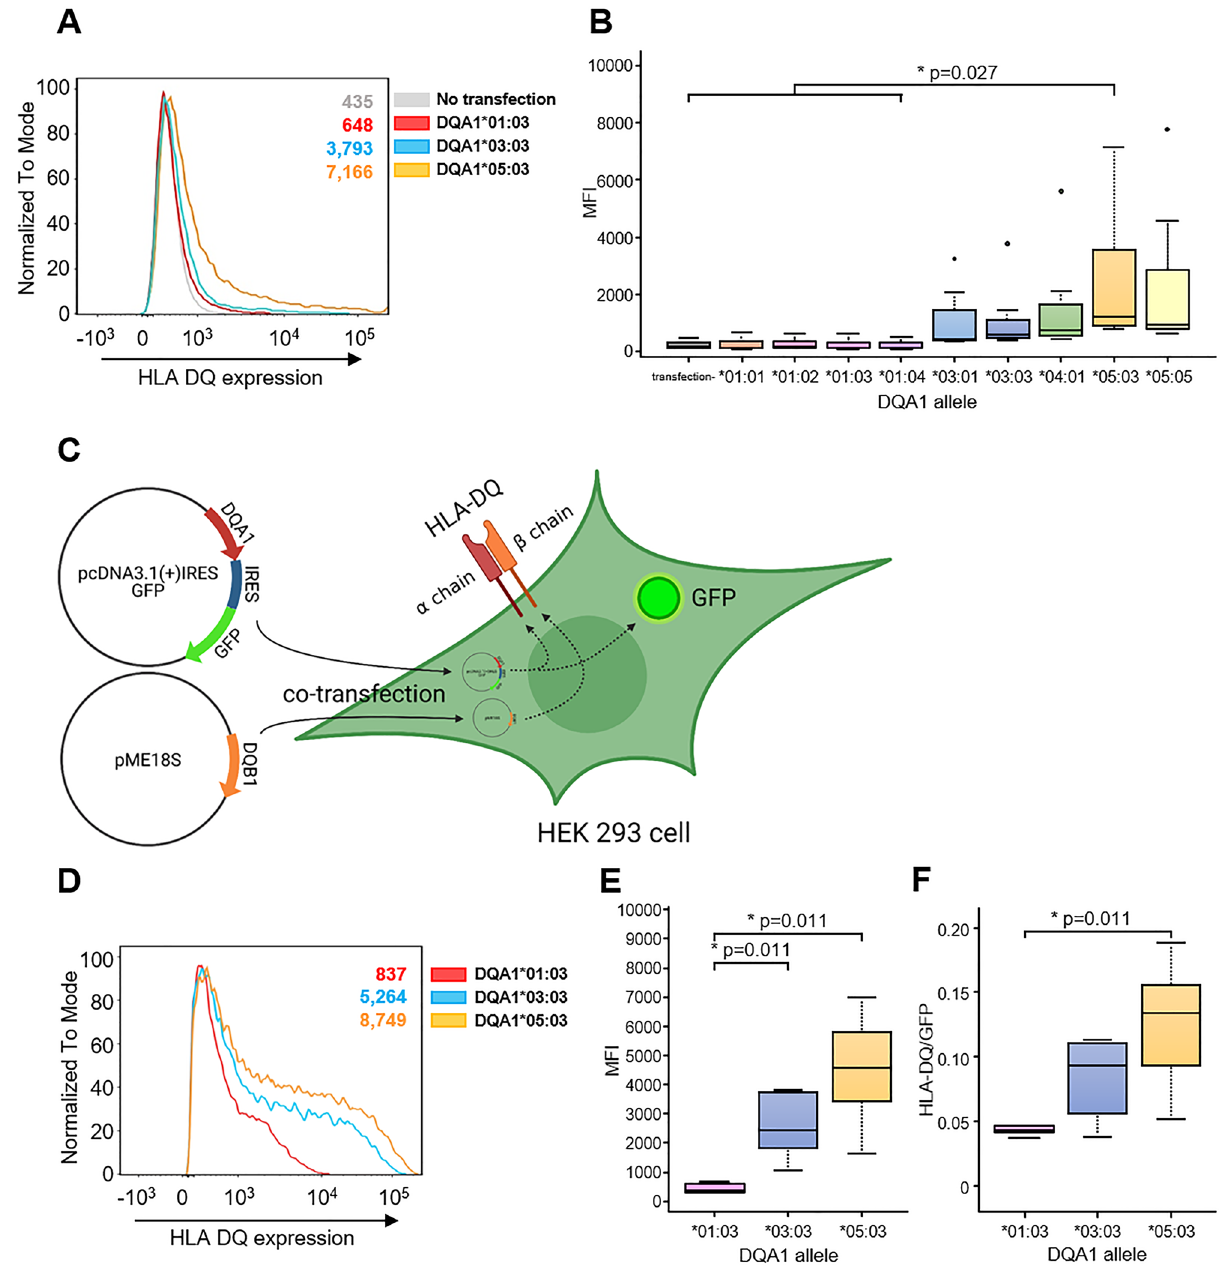
Figure 1. Expression of HLA-DQ molecules in HEK293 cells. ( A ) Representative cell-surface expression of HLA-DQ molecules in HEK 293 cells which were transiently co-transfected with HLA-DQA1 and HLA-DQB1 expression vector. HLA-DQA1*01:03 (red), DQA1*03:03 (blue) and DQA1*05:03 (yellow) were selected as the HLA-DQA1 expression vectors and the paired HLA-DQB1 expression vector were all HLA-DQB1*03:01 . HEK293 cells that were not transfected with any HLA expression vector are shown as a negative control (gray). The numbers on the upper right of the graph denote mean fluorescence intensity (MFI) of HLA-DQ of the HEK293 cells. ( B ) Summary of HLA-DQ expression with nine DQA1 expression vectors. HEK293 cells which were not transfected with any HLA expression vector are shown as “transfection-”. ( C ) Schema of co-transfection of pcDNA3.1 (+) IRES GFP plasmid vector that co-expresses GFP and DQA1 allele, and pME18S plasmid vector that expresses DQB1 allele into HEK293 cells. At 48-eight hours after transfection, the cell surface HLA-DQ and cellular GFP level were analyzed by flow cytometry. This schema was created with BioRender.com. ( D ) Representative cell-surface expression of HLA-DQ molecules in GFP-positive HEK 293 cells. GFP expression vector was constructed for HLA-DQA1*01:03 (red), DQA1*03:03 (blue) and DQA1*05:03 (yellow). All HLA-DQB1 expression vector was DQB1*03:01 . The numbers on the upper right of the graph denote the MFI of HLA-DQ of the GFP + HEK293 cells transfected with each DQA1 allele. ( E ) HLA-DQ expression with three DQA1 expression vectors in GFP positive HEK293 cells. ( F ) The MFI (HLA-DQ)/MFI (GFP) ratio of GFP positive HEK293 cells for each HLA-DQ allelic